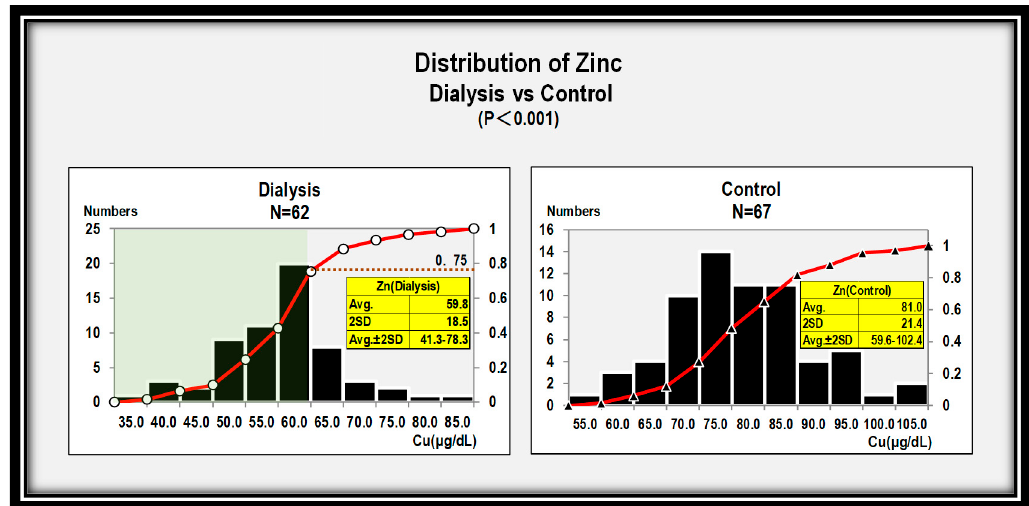
Figure 1. Significant differences in zinc level distributions are seen in the dialysis group versus the control group ( P < 0.001).